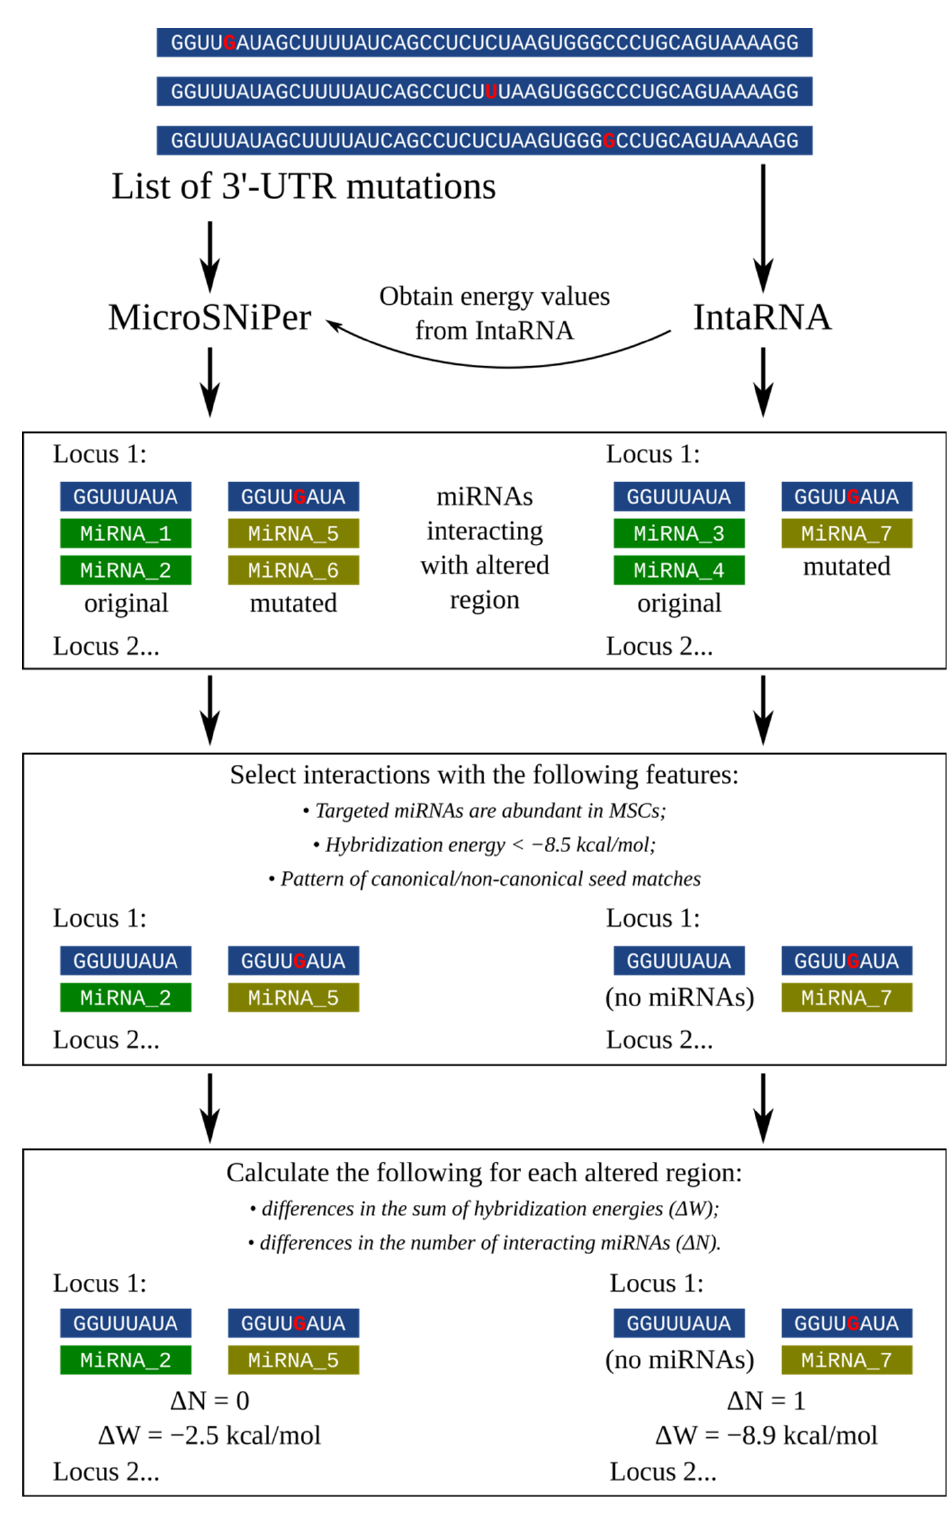
Figure 1. The general workflow for prediction of 3 ′ -UTR mutations effect on miRNA tissue-specific targeting. The pipeline shows the process of evaluating miRNA targets for altered and original DICER1 and DROSHA loci in the context of MDS (tissues-specific analysis in MSCs). Mutation sites are indicated in red.